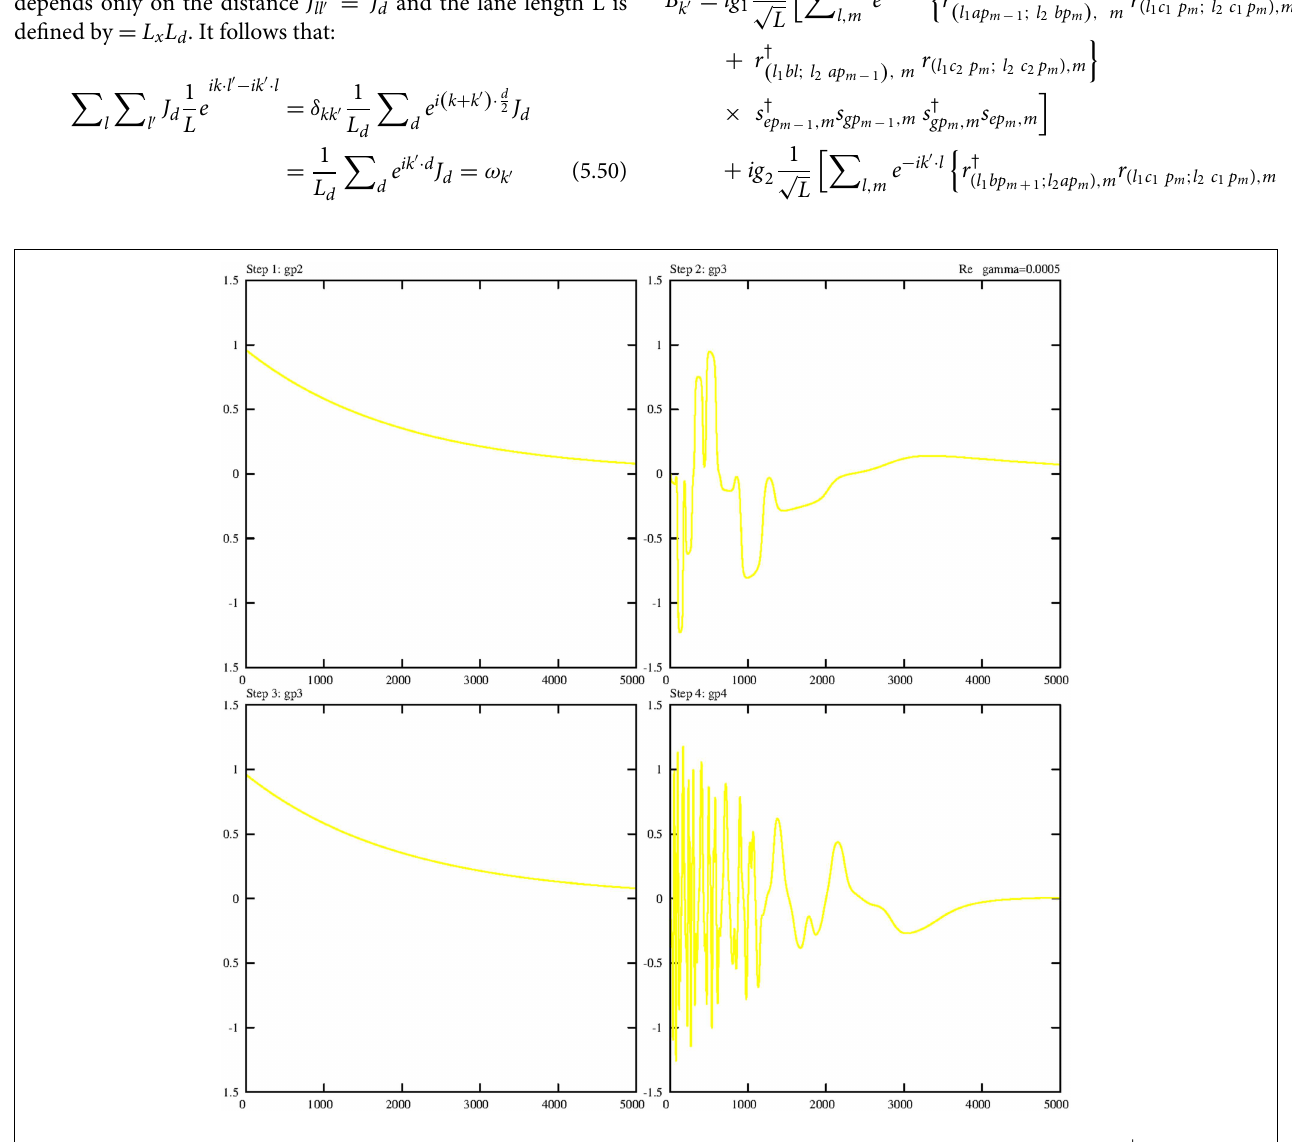
equivalents for the selected operators are introduced: gp 2 , gp 4 . The value of the damping constant is set to γ s † gp s † gp 3 4 = The coupling constants are g 1 g 2 0 . 1 = =